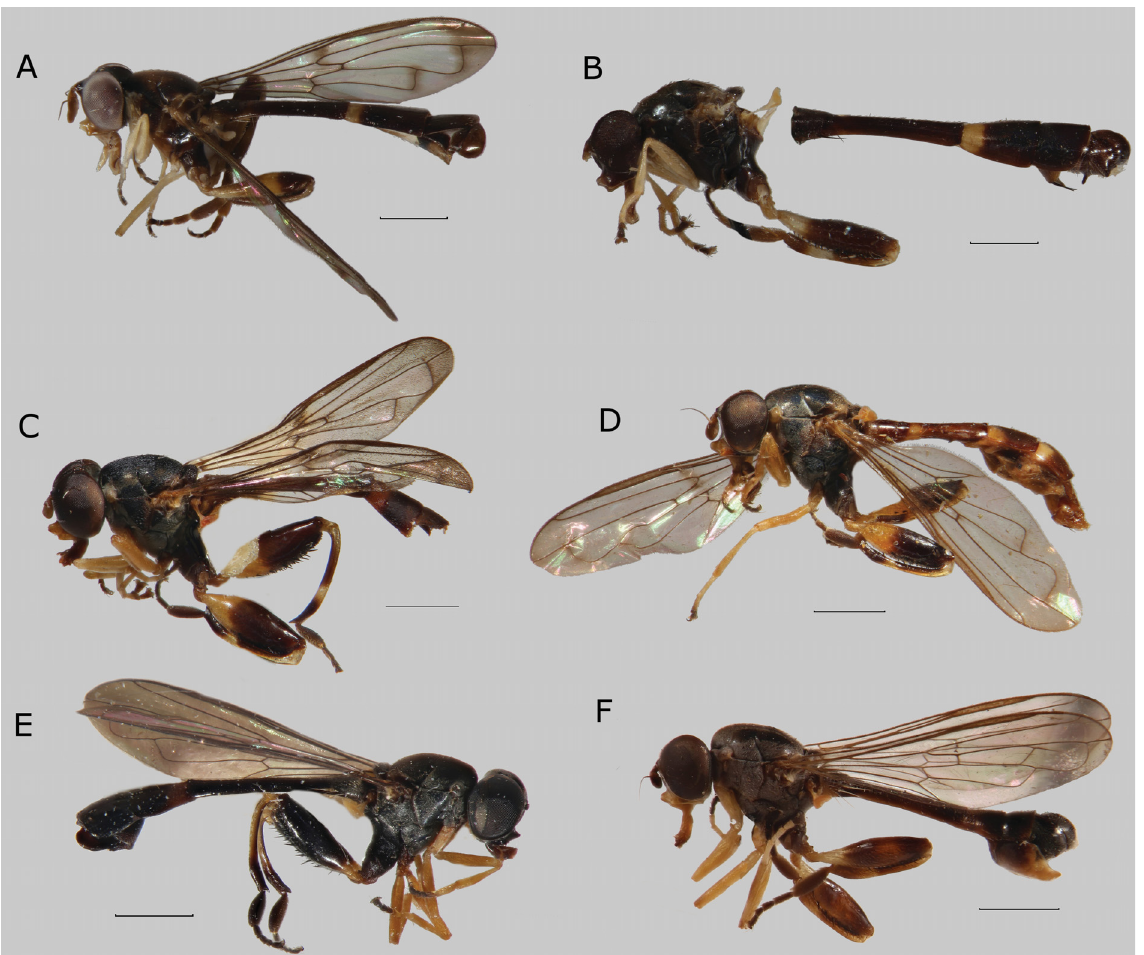
Fig. 45. Habitus, lateral view. A . Sphegina (Asiosphegina) incretonigra sp. nov., holotype, ♂ , Vietnam. B . S. (A.) index Hippa, van Steenis & Mutin, 2015, holot ype, ♂ , Myanmar. C . S. (A.) in fl ata sp. nov., holotype, ♂ , Philippines. D . S. (A.) cf. in fl ata sp. nov., ♀ , Philippines. E . S. ( A.) inventum sp. nov., holotype, ♂ , Sabah, Malaysia. F . S. ( A.) javana de Meijere, 1914, lectotype ♂ , Java, Indonesia. Scale bars = 1.0